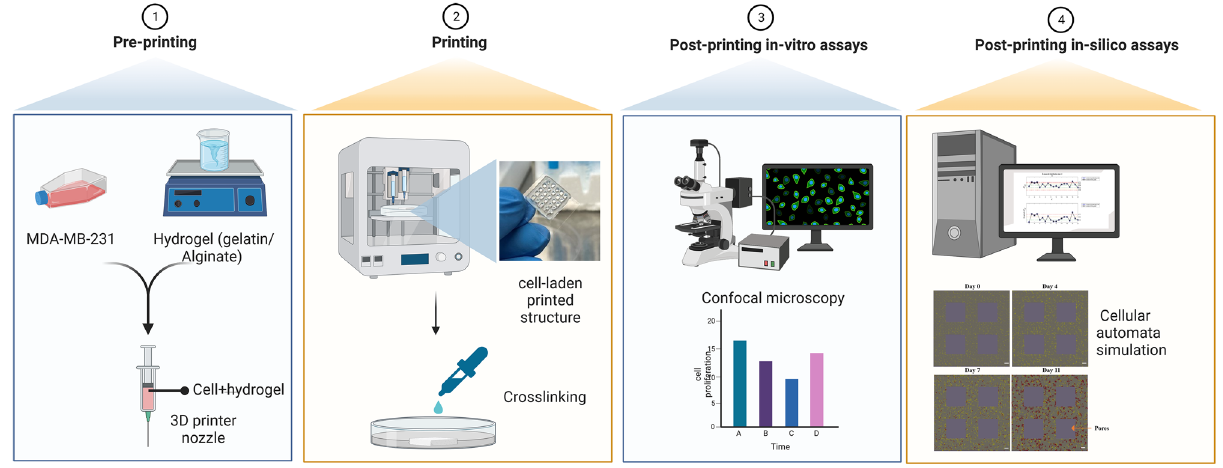
Figure 1. Schematic illustration of the main steps involved in this study; step 1: preparing bioink consisting of gelatine, alginate, and MDA-MB-231 cell line; step 2: printing and crosslinking the cell-laden 3D structure; step 3: performing post-printing in-vitro assays; step 4: developing and calibrating an in-silico model. Created with